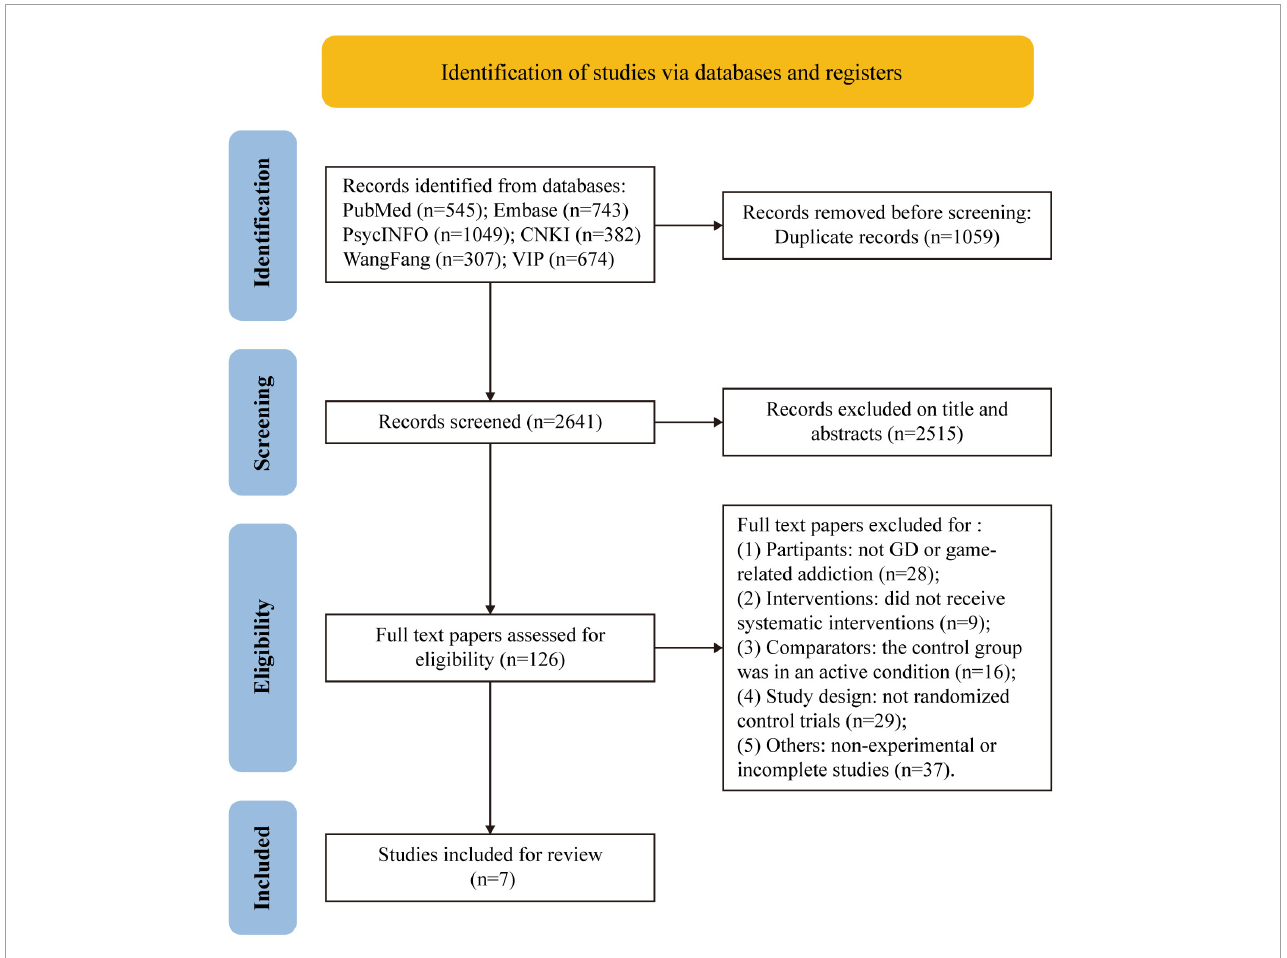
FIGURE1 PRISMA flow diagram of the study selection